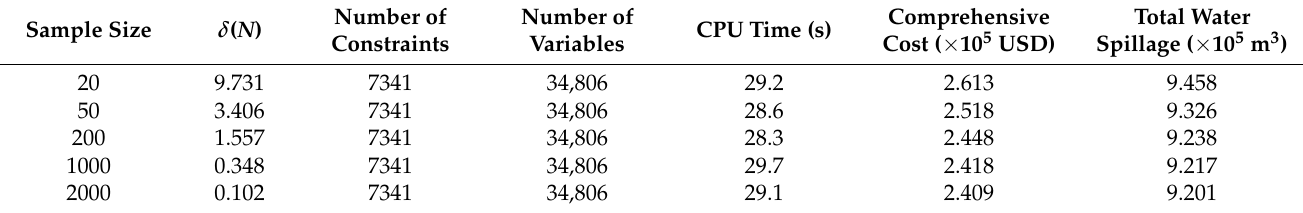
Table 3. Test results of DR-DOPF under various sample